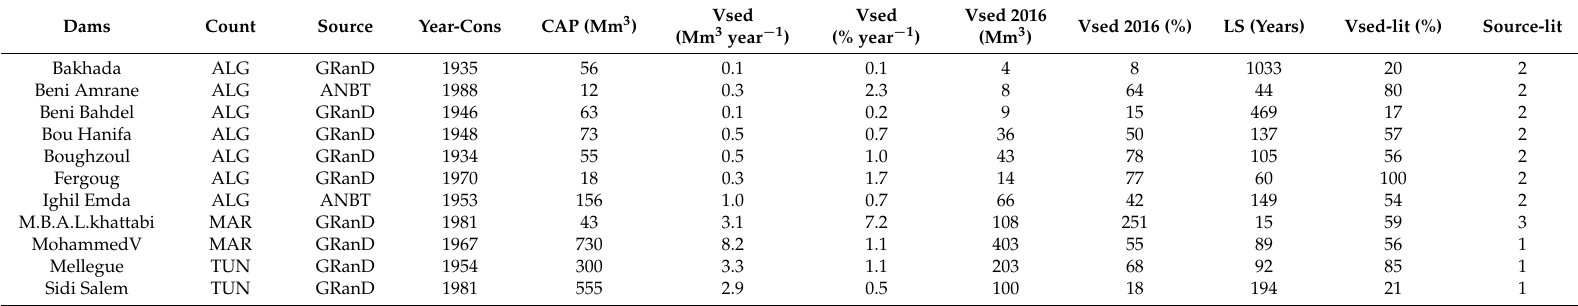
LS (Years) Vsed-lit (%) Source-lit